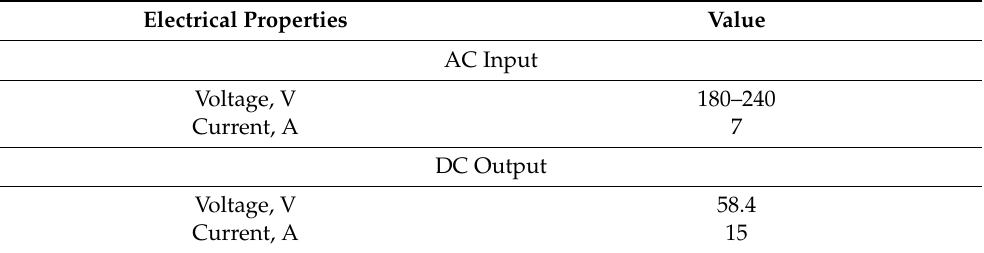
Table 2. Technical characteristics of the